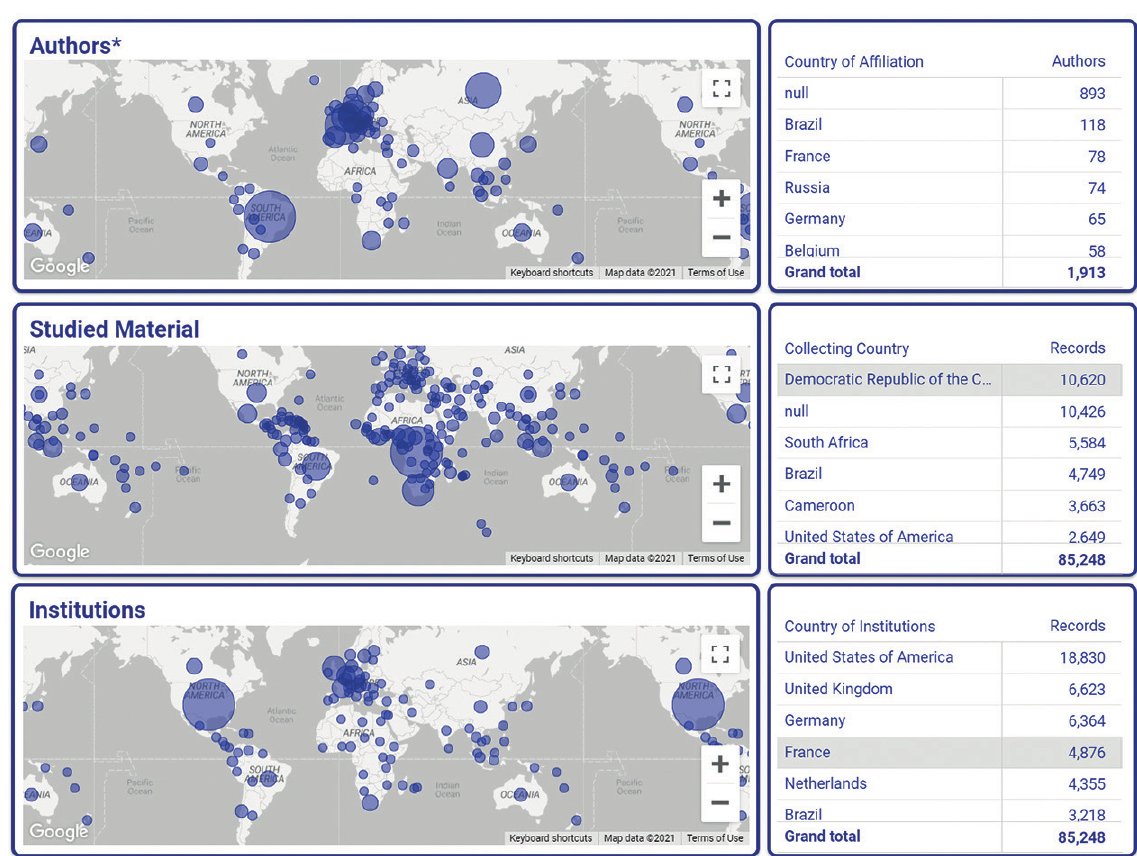
Fig. 7. Comparison of the location of the study author, the origin of the studied material and the institution or collection where the specimen referenced in the material citation is